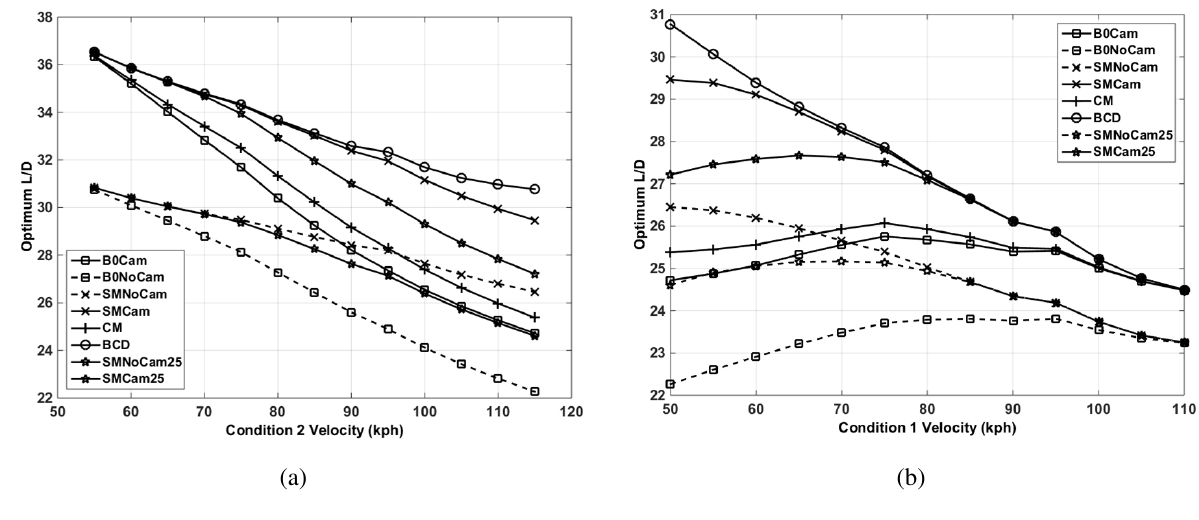
Figure 10. Aerodynamic efficiency for the designs over variable speed ranges. ( a ) Aerodynamic efficiency for low speed fixed at 50 kph; ( b ) aerodynamic efficiency for high speed fixed at 115 kph.